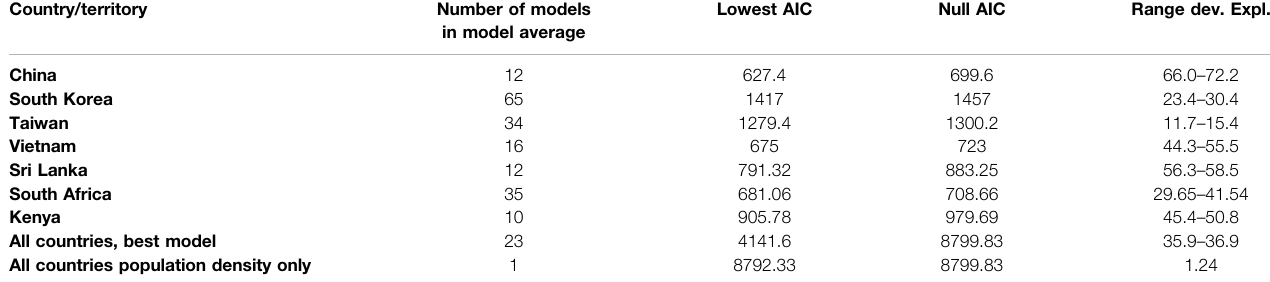
TABLE 3| Description ofmodels used inthe model averaging (allwithin2 AIC values). LowestAIC indicates thelowest AIC valuefor the models withineach ofthecountries. Modelsinthemodel averagingareallwithin2AIC pointsofthelowest.NullAIC istheAIC ofaregressionwithno covariatesincluded.NotethattheAIC valuescannotbe compared between countries, because they are using different data sets. AIC values can be compared between all countries, and all countries with population density only because they are using the same data set. Country/territory